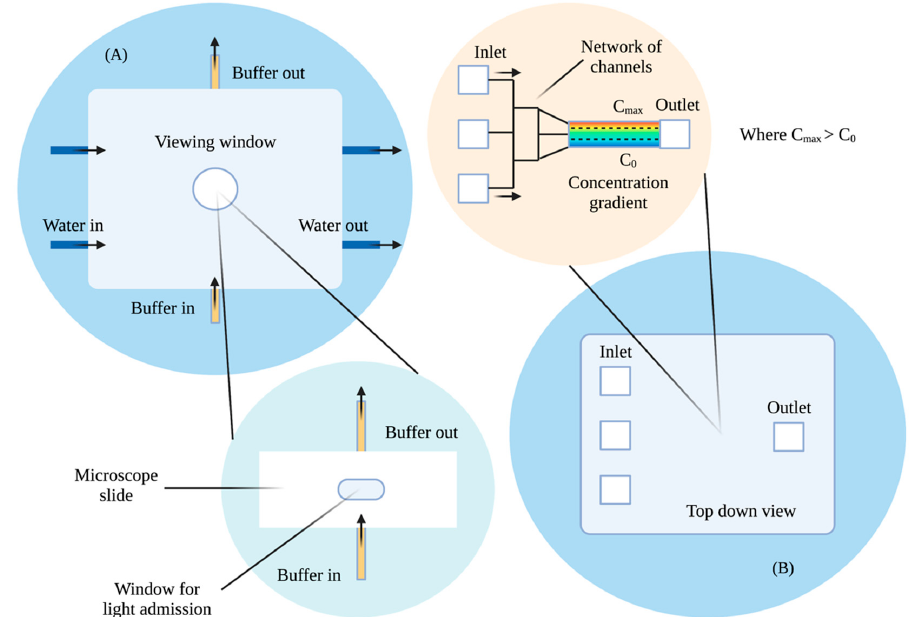
Figure 2. Simplistic adapted diagram highlighting: ( A ) Fisher’s chemotaxis chamber for the quanti- tative analysis of D. discoideum, with a microscope slide at the bottom and a viewing window at the top for image analysis and ( B ) a top-down view of Jeon and colleagues’ microfluidic gradient generator with an embedded network of channels inside. Arrows indicate the direction of fluid flow. Created with BioRender.com (https://app.biorender.com/). Last accessed on 13 October 2022.